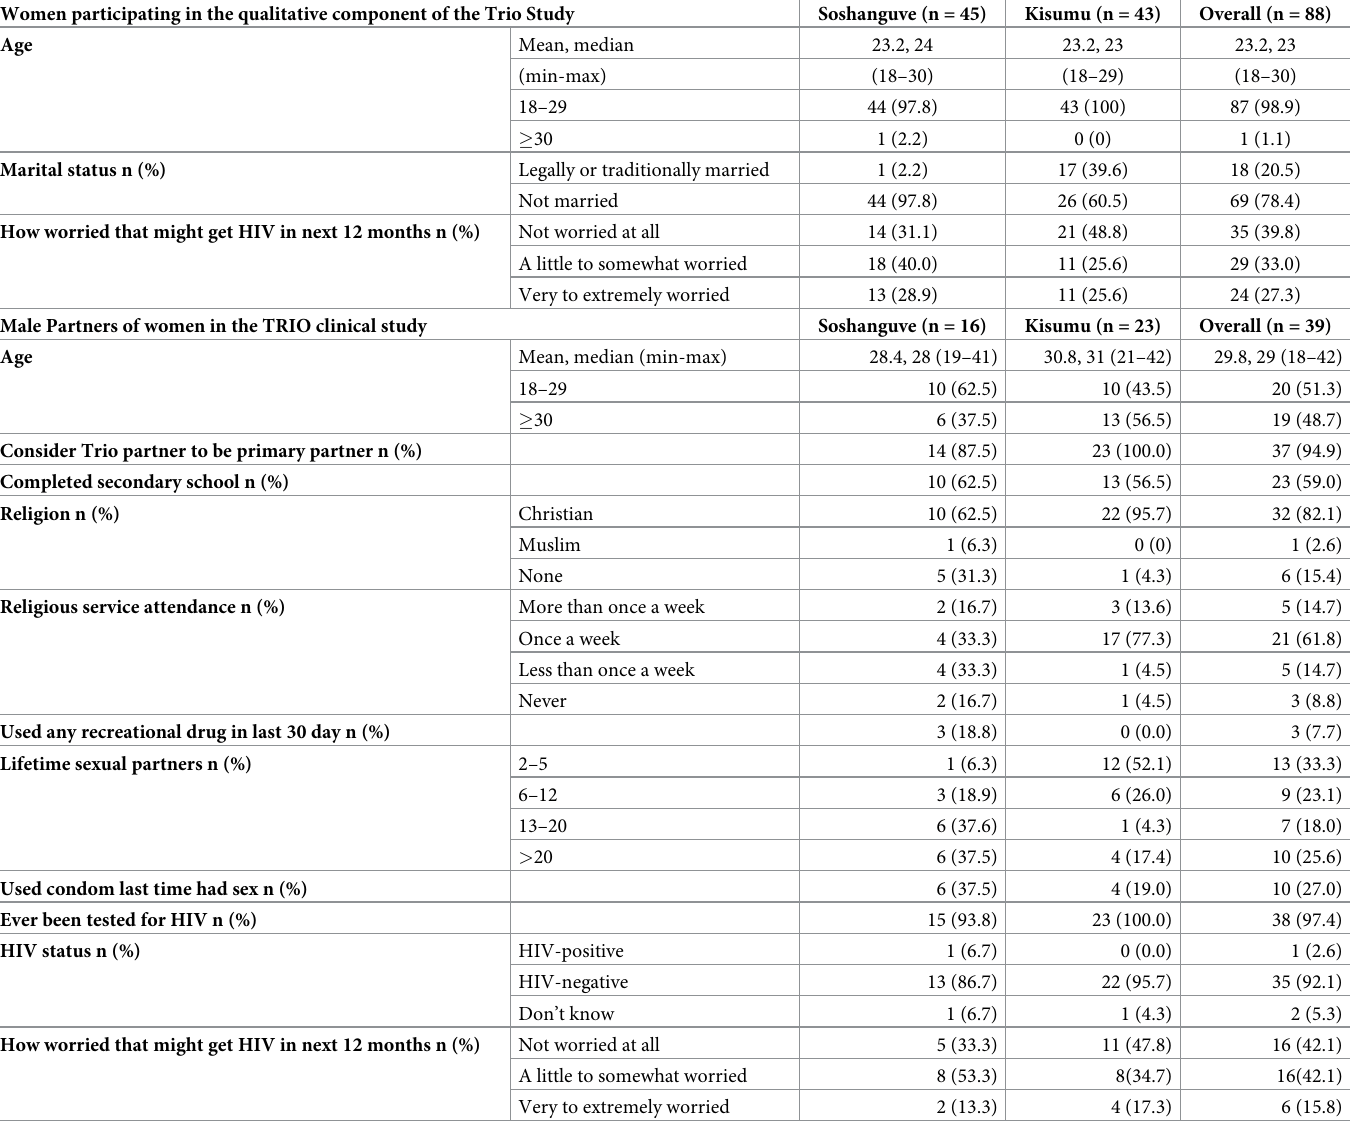
Table 1. Baseline characteristics of women participating in the qualitative component of the Trio study and Trio participant male partners, Soshanguve, South Africa and Kisumu, Kenya. Women participating in the qualitative component of the Trio